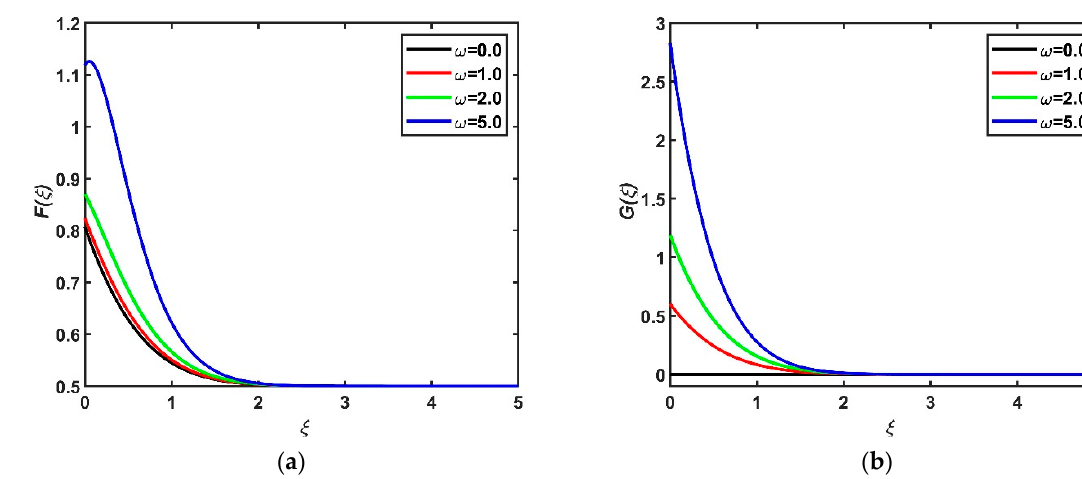
Figure 5. Impact of 𝐻𝑎 on ( a ) 𝐹(𝜉) and ( b ) 𝐺(𝜉) .